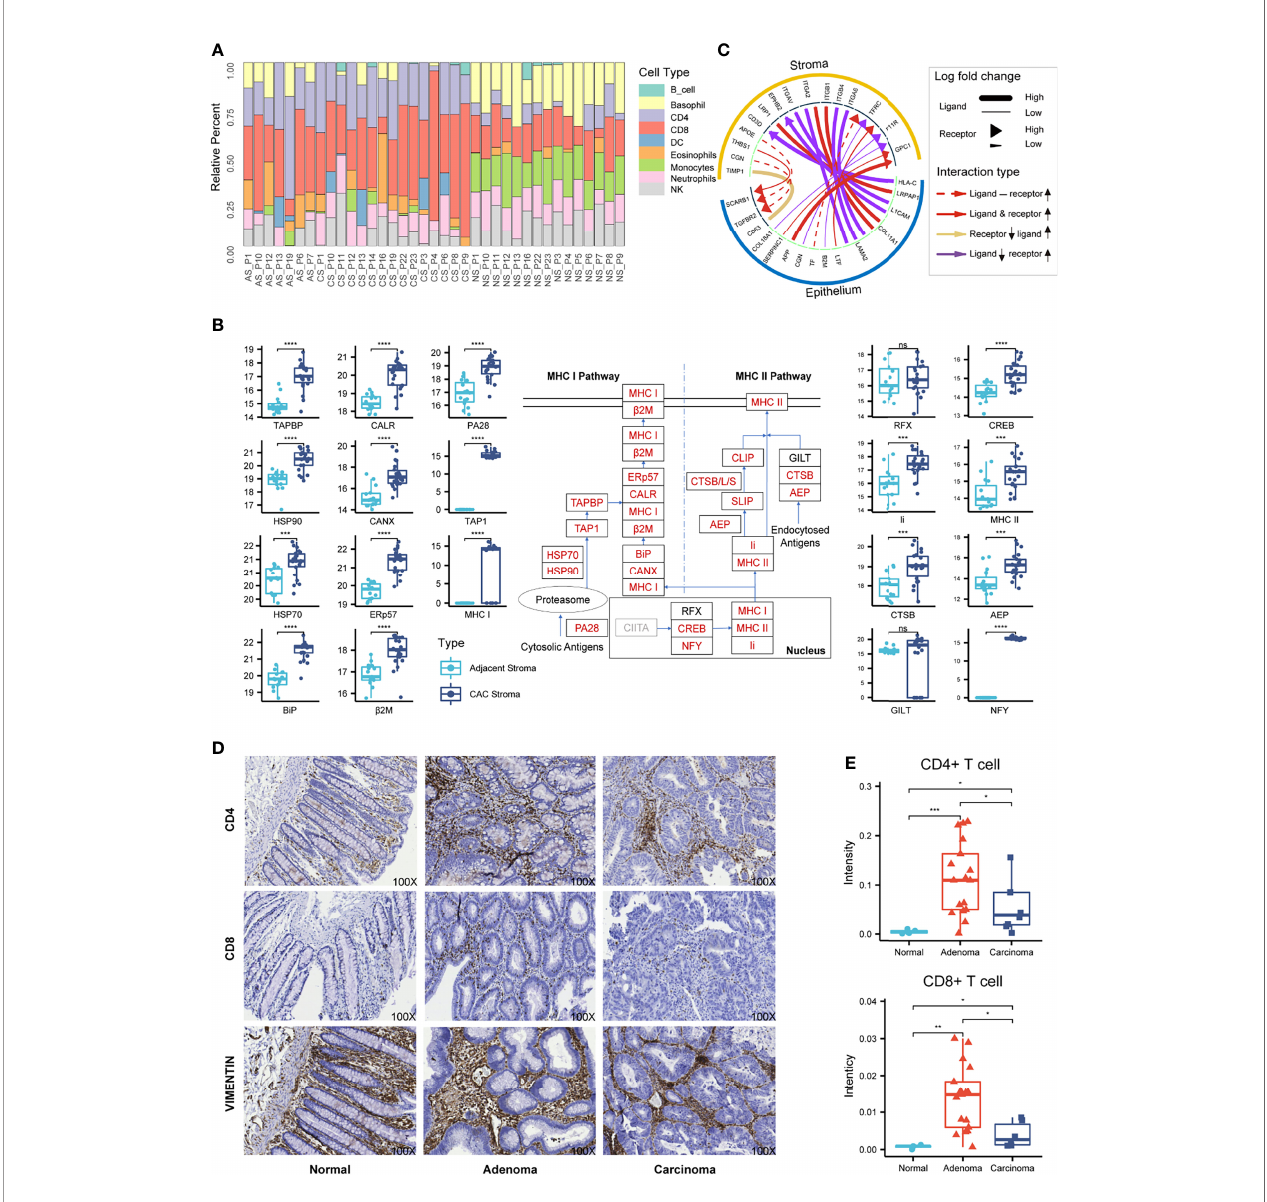
FIGURE 4 | Characterization of the stromal proteomes in the adjacent, adenoma, and carcinoma tissues. (A) Distribution of immune cell in fi ltration in the stromal tissues of adjacent, adenoma, and carcinoma based on analysis of CIRBERSORTx to the stromal proteomes. The pre fi x of sample names in the x-axis is the abbreviation of tissue type: AS, CS, and NS represent adjacent stroma, adenoma stroma, and carcinoma stroma, respectively. (B) Statistical evaluation to the abundance of the stromal proteins participating in the antigen presentation pathway between the adjacent and CAC tissues. The diagram of this pathway is placed at the center, in which the rectangles with red stand for the upregulated proteins, with black for no signi fi cant change and with gray for unidenti fi ed. The boxplots of abundance comparison are depicted on the left for the proteins in MHC I and on the right for those in MHC II and the nucleus. The signs of *, **, ***, and **** represent a signi fi cance with p < 0.05, p < 0.01, p < 0.001, and p < 0.0001, respectively, and ns, represents nonsigni fi cance. (C) The typical ligand – receptor interactions between the stromal and epithelial proteins predicted by iTALK. (D) The representative IHC images using CD4, CD8, and vimentin antibody on the tissue microarray of CRC. Original magni fi cation, ×100. (E) Statistical comparison of the CD4 or CD8 staining intensities among the normal, adenoma, and carcinoma stromal tissues in the tissue microarray of CRC. The signs of *, **, and *** represent a signi fi cance with p < 0.05, p < 0.01, and p < 0.001,